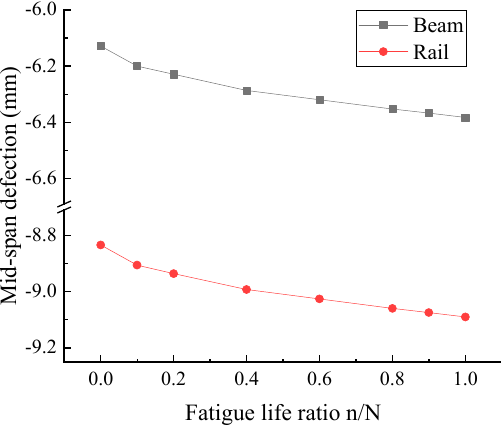
Figure 11. Mid-span deflection response curve of the support beam and the rail under fatigue load.